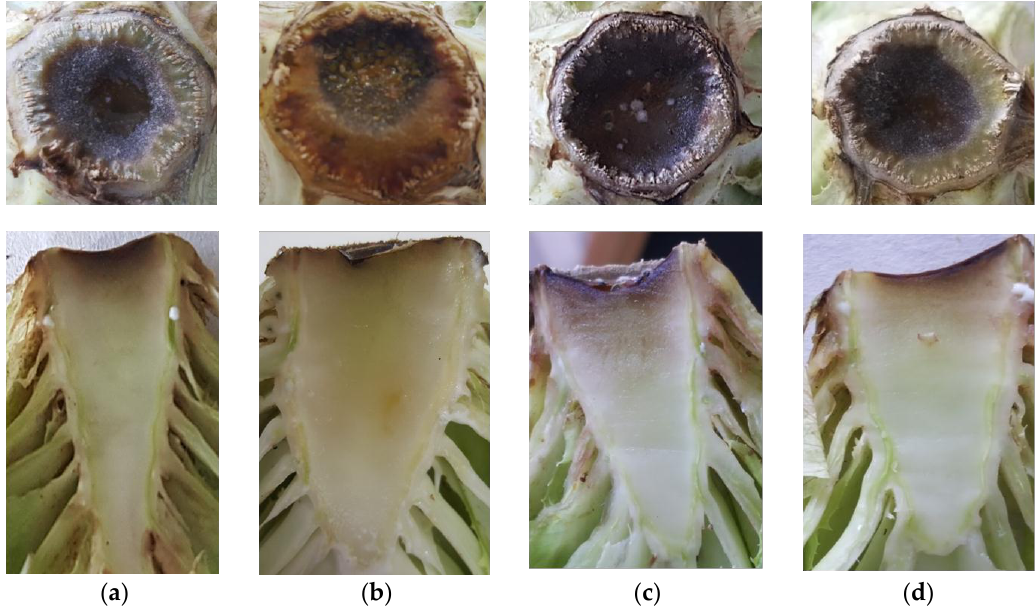
Figure 9. In vivo symptoms (external and internal damages) developed after five days due to artificial inoculation by Pectobacterium carotovorum subsp. carotovorum (DSM 30184 [Leibniz Institute German Collection of Microorganisms and Cell Cultures, Germany]) bacterial plant pathogen on Romaine lettuce after preventive treatments by chitosan hypochloride and chemical compound (Sodium hypochlorite) respect to the control thesis (treated only by P. c. subsp. carotovorum and, as control negative, only by SDW). ( a ) Control positive: P. c. subsp. carotovorum bacterial plant pathogen at 1 × 10 6 CFU/mL; ( b ) Control negative, SDW; ( c ) Chitosan hydrochloride (1 g/L) solution; and ( d ) Sodium hypochlorite (1 mL/L) solution ( p = 0.01). Chitosan hydrochloride and Sodium hypochlorite (Sigma-Aldrich ® , St. Louis, MO, USA).